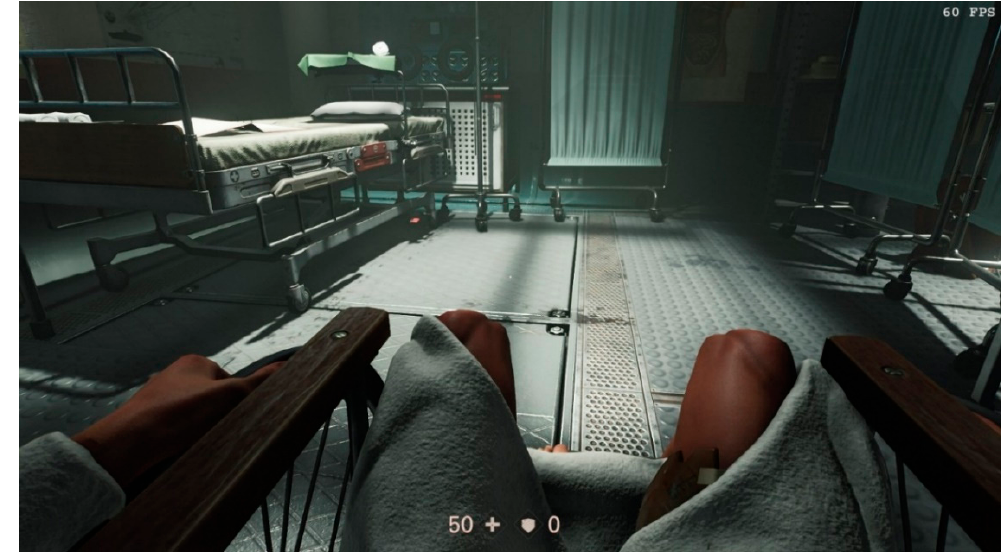
Figure 3. Hero in wheelchair, bathrobe, and catheter.